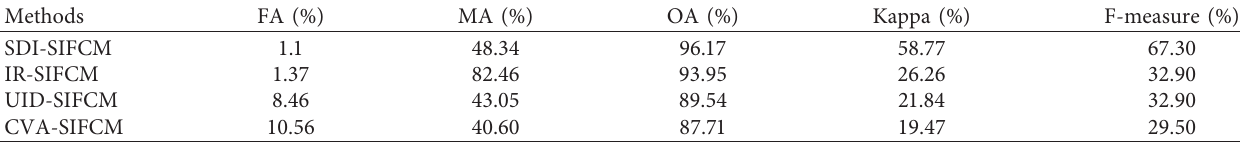
Table 1: Accuracy evaluation of the first comparative experiment of the first group of images. Methods